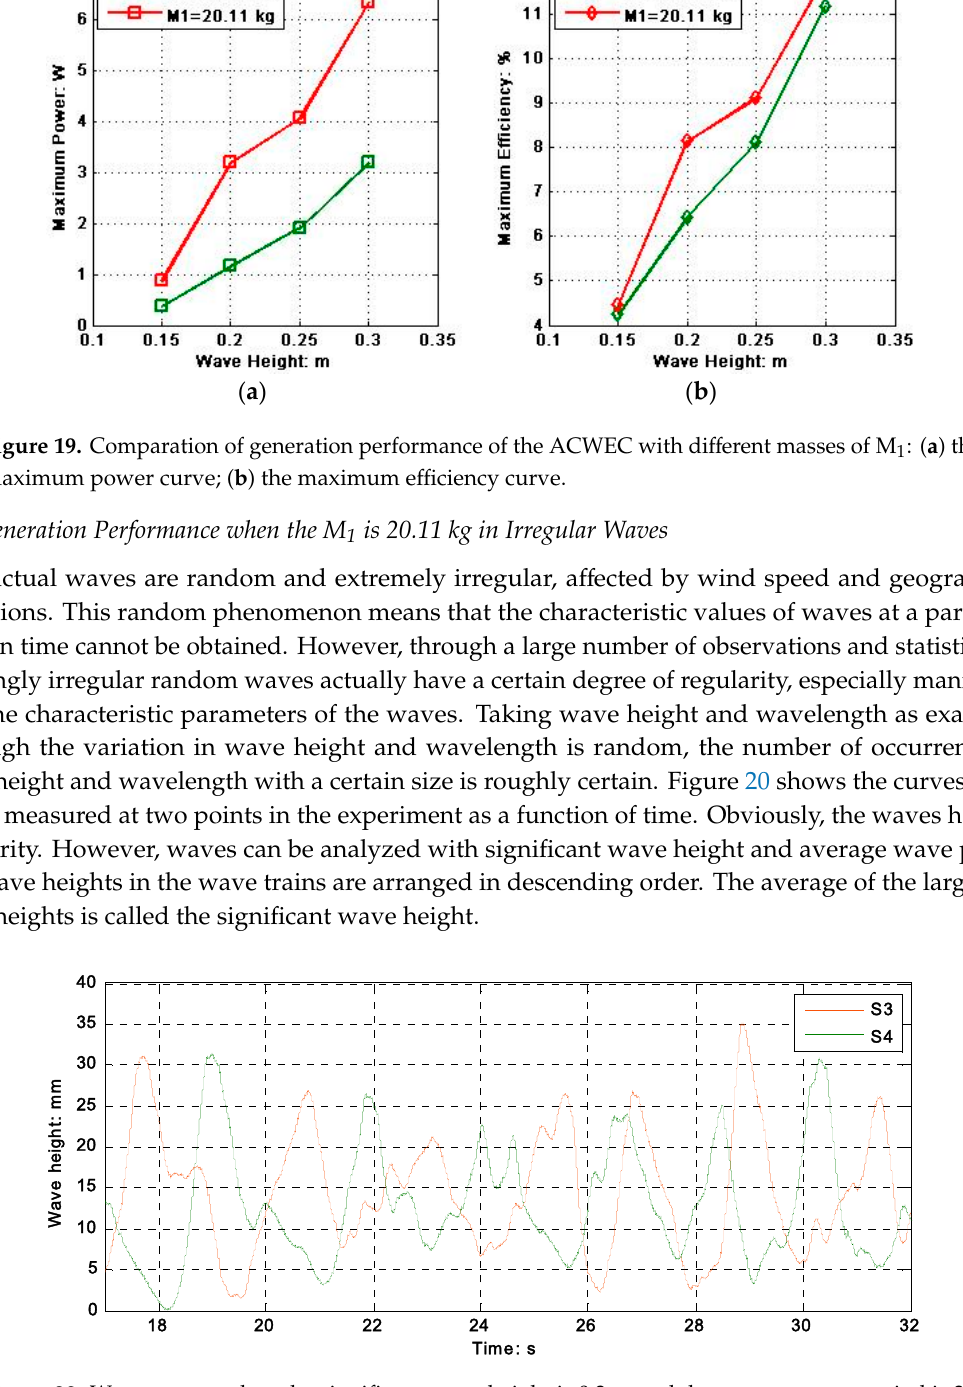
Figure 20. Wave curves when the significant wave height is 0.3 m and the average wave period is 3 s. (S3 is the wave curve before the ACWEC; S4 is the wave curve after the ACWEC.).